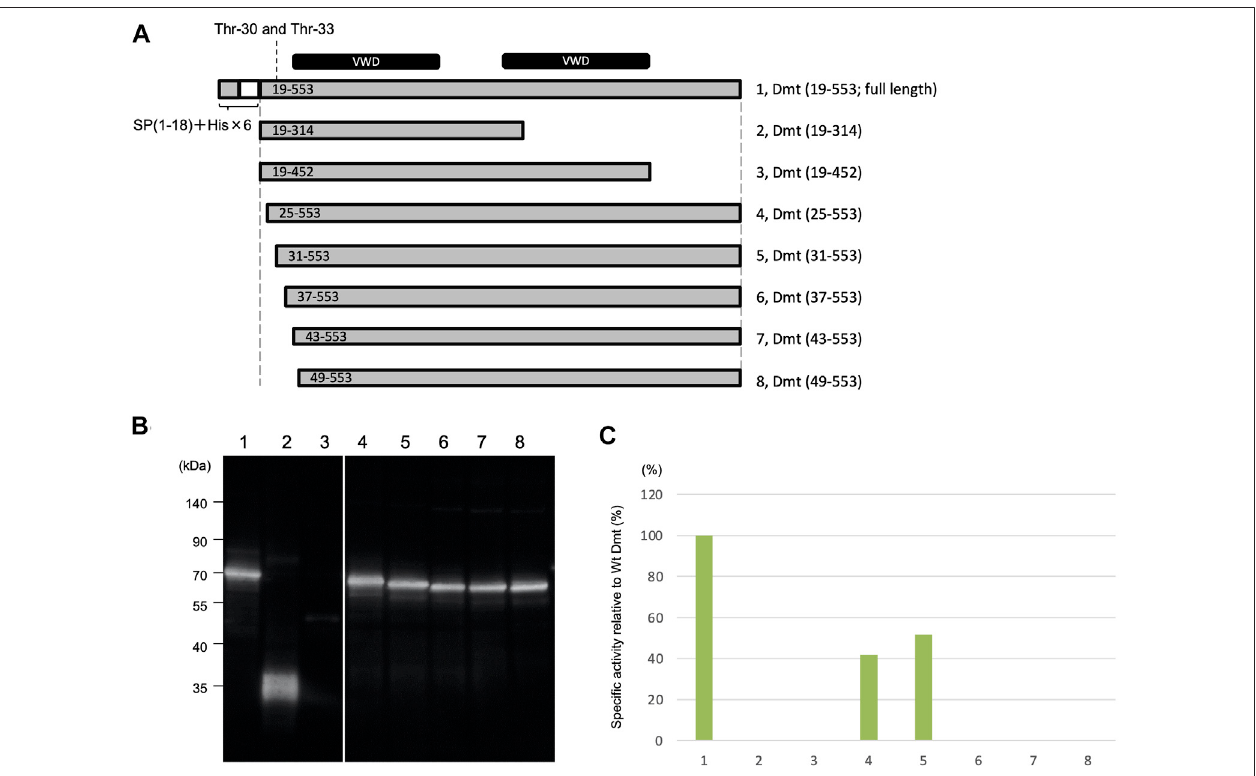
FIGURE 3 | Luminescence activities of Dmt CLuc EX deletion mutants. (A) Schematic representation of full-length Dmt CLuc EX and its deletion mutants. Each constructwasdesignedtohaveanaturalsignalpeptide(SP1 – 18)andHistag(His×6) – TEVsequenceattheaminoterminus.TheO-glycosylationsitesareat30and33. VWD-likedomainsareindicatedbyblackbarsatthetopofthepanel. (B) ImmunoblotanalysisofDmtCLuc EX deletionmutants.Expi293Fcellsweretransfected withthe indicated constructs, and theproduced protein secreted intothe medium wasanalyzedby Western blottingusing anti-CLucantibody. (C) Relative speci fi cactivity of each Dmt CLuc EX deletion mutant. Speci fi cCLuc EX activities were determinedas shown in Figure 1 . Note that theband in lane3 isvery faint,probably due to thelow expression level of this construct.